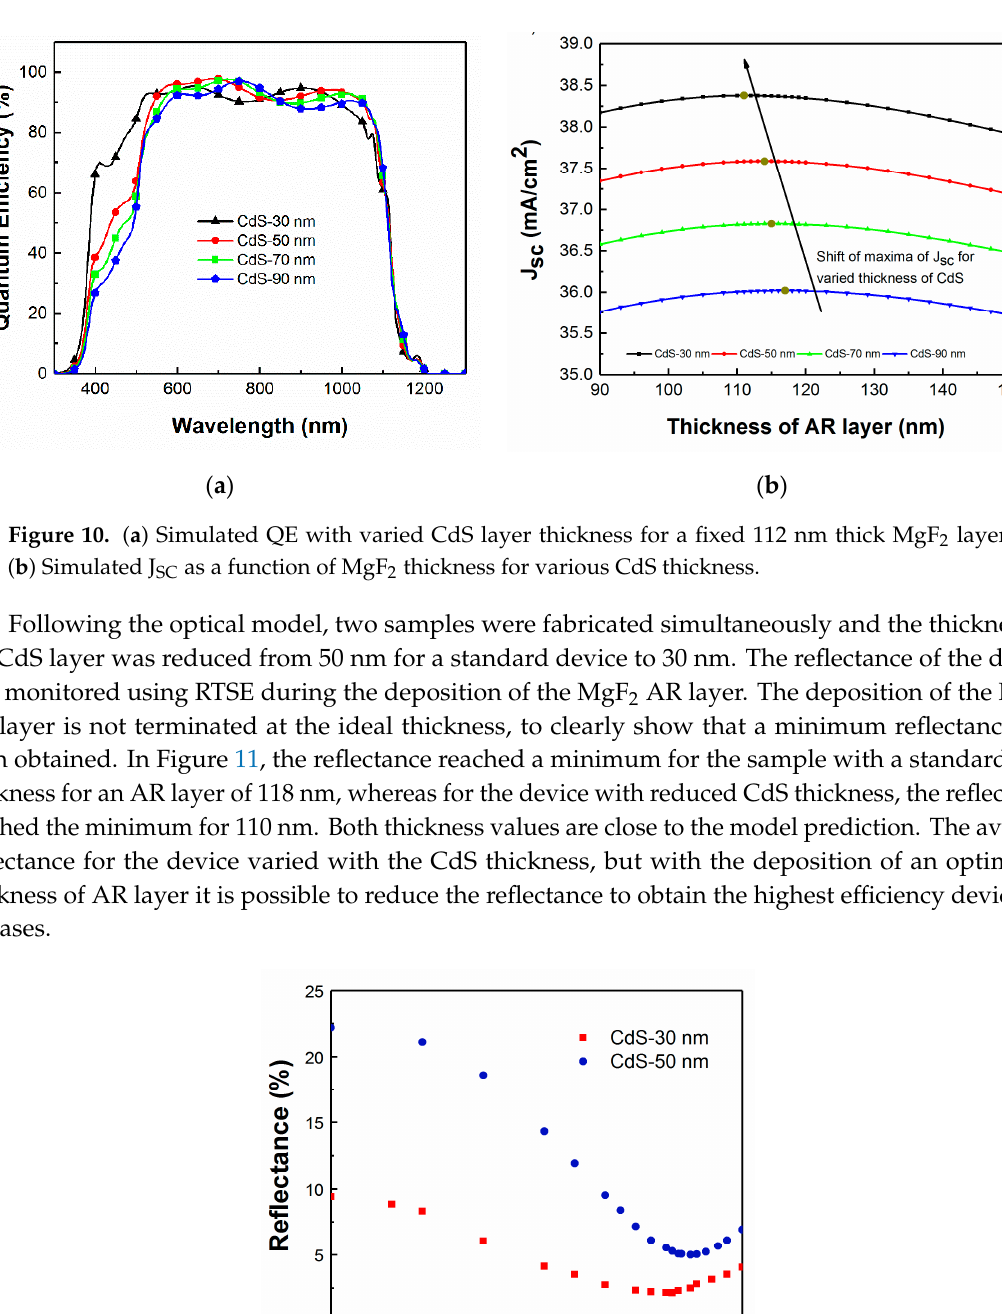
Figure 12. Measured J–V curves for CIGS solar cells with a 30 nm thick CdS layer and either no AR coating, a 118 nm prior modeled AR coating thickness, or a 110 nm in-situ optimized AR coating thickness (insert: close up of the − 0.1 V to 0.1 V zone). The thickness of the AR layer is predicted to be approximately 110 nm for CIGS devices with a thin 30 nm thick CdS layer to maximize the J SC. The effect of having deposited the optimized AR layer on the device with thin CdS is demonstrated in Figure 12. There is a clear enhancement in the J SC for the new optimized layer when compared to depositing the standard 118 nm AR layer. 3.2.3. Optimizing the AR Layer as a Function of the AZO Layer Thickness Similar to the variation in CIGS and CdS layer thicknesses, the AZO layer thickness and optical response is quite often different between one fabrication laboratory and another, without even considering the use of an alternate material such as indium tin oxide. AZO layer thickness is therefore varied and the AR coating is optimized according to the change in the structure. The optical model was used to predict the QE and J sc of the CIGS device with 150 and 300 nm AZO window layer thicknesses (Figure 13).